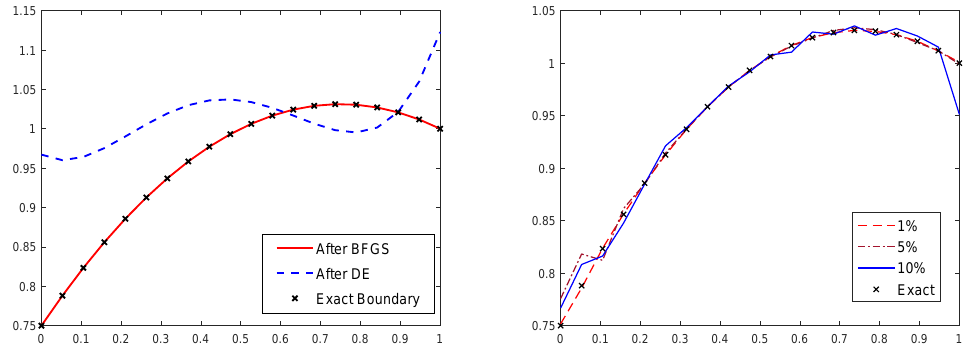
Figure 3. Results for example 2 without noise ( left ), with different noise level ( right